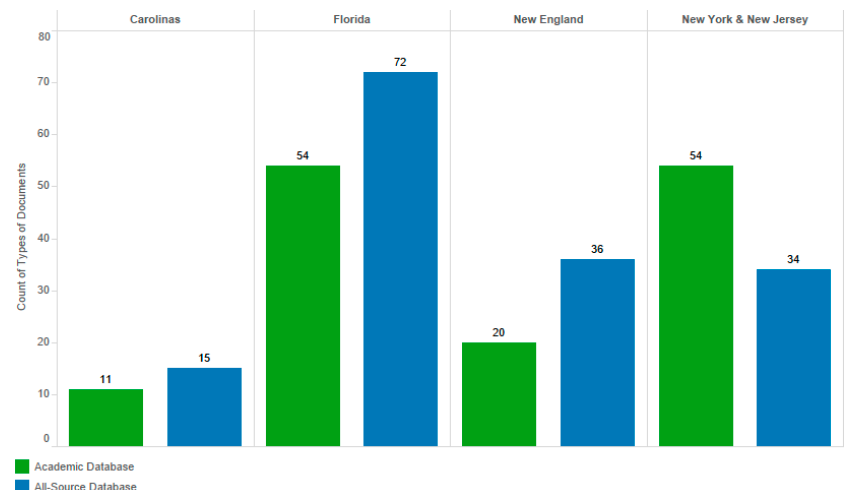
Figure 3. Sub-regional totals of adaptation literature returns by the two types of databases. SE U.S. sub-regions: Carolinas (CR) and Florida (FL). NE U.S. sub-regions: New England (NE) and New York/New Jersey (NY/NJ).